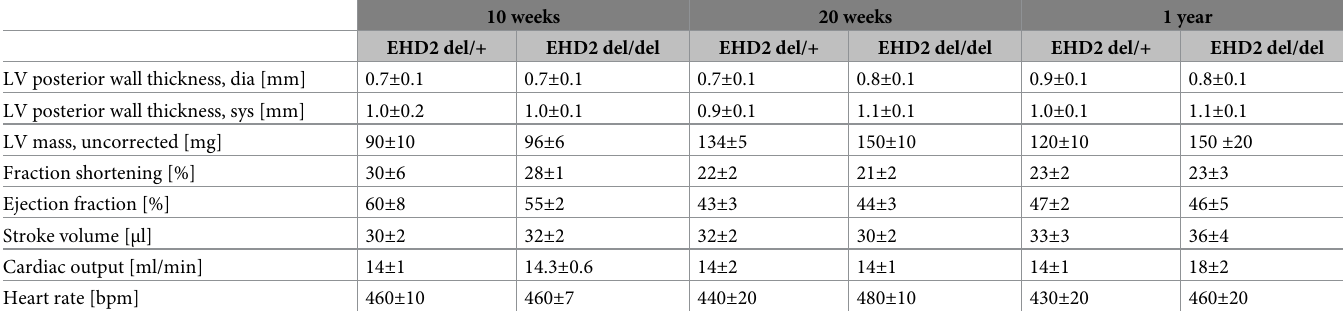
Table 1. Echocardiographic measurements of EHD2 del/+ and del/del